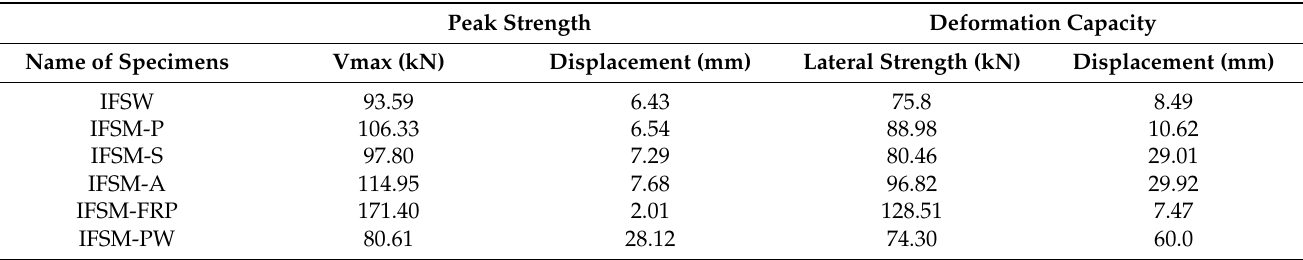
Table 1. The peak strengths and deformation capacities of specimens.